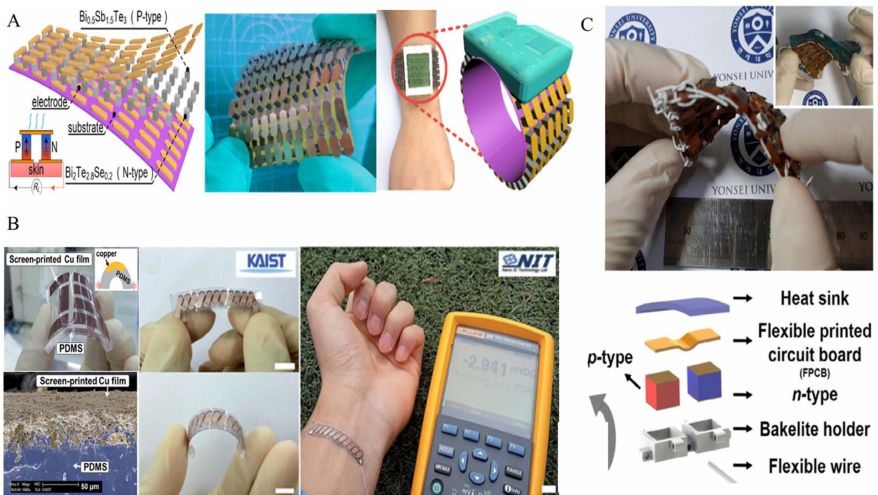
Figure 5. ( A ) Structural design and fabricated images of ns-FTEGs and FTEGs-powered wearable multi-sensory bracelet [49]. ( B ) Schematic illustration of the flexibility of the embedded Cu film (Cu foil vs. the screen-printed Cu film) in PDMS and demonstration of band-type flexible TE generator for harvesting thermal energy from human skin at an air temperature of 15 ◦ C (scale bar, 1 cm) [50]. ( C ) Schematic design and structure of ns-FTEGs encapsulated by bakelite